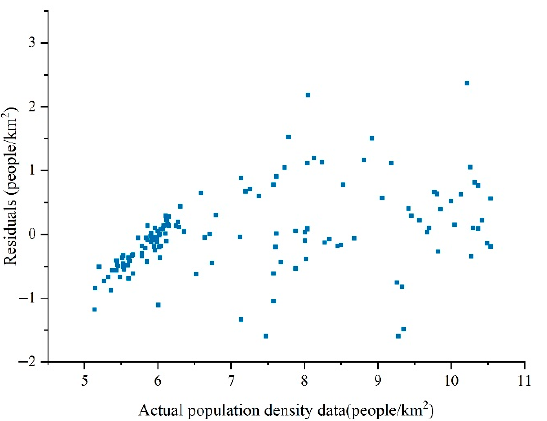
Figure 11. Residuals (on a log scale) between the estimated population density and the corresponding actual population density at the township scale.